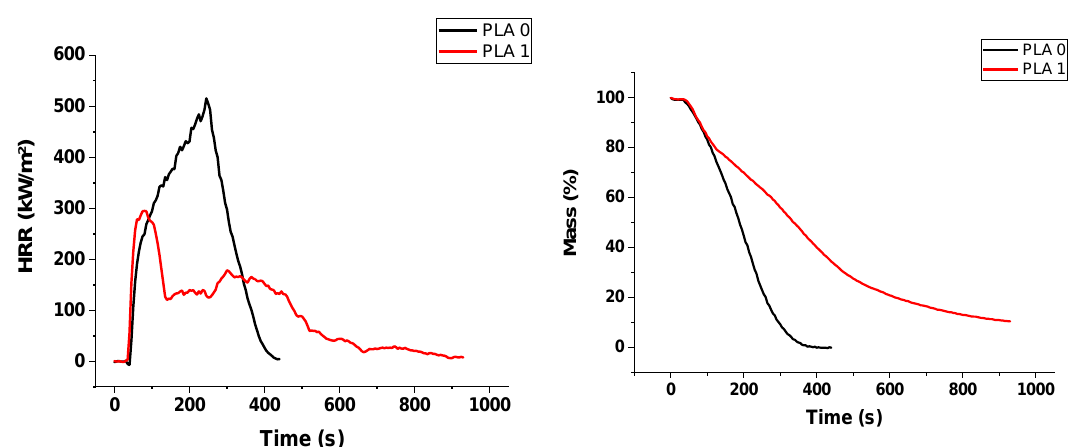
Figure 5. Heat release rate and mass for PLA/APP composites from cone calorimeter.